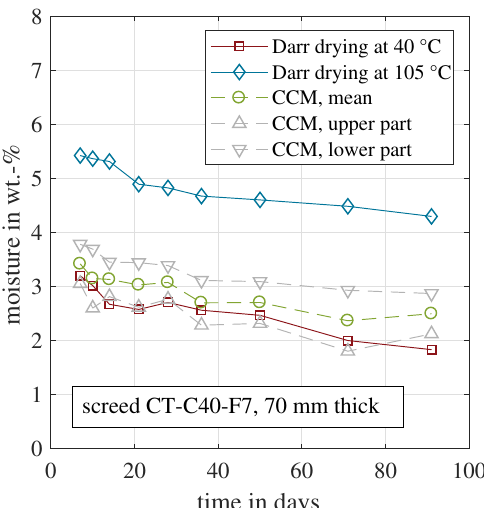
Figure 5. Evolution of the material moisture measured by CCM and Darr drying for the cement-based samples